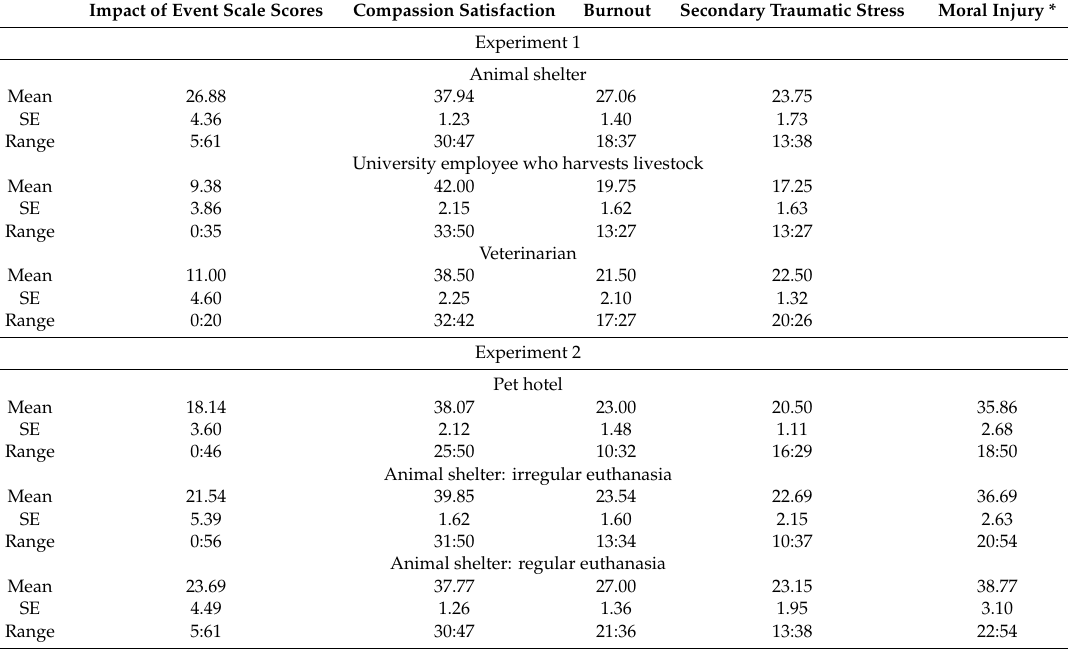
Table 3. The averages of the psychometric measures across jobs for Experiments 1 and 2. Impact of Event Scale Scores